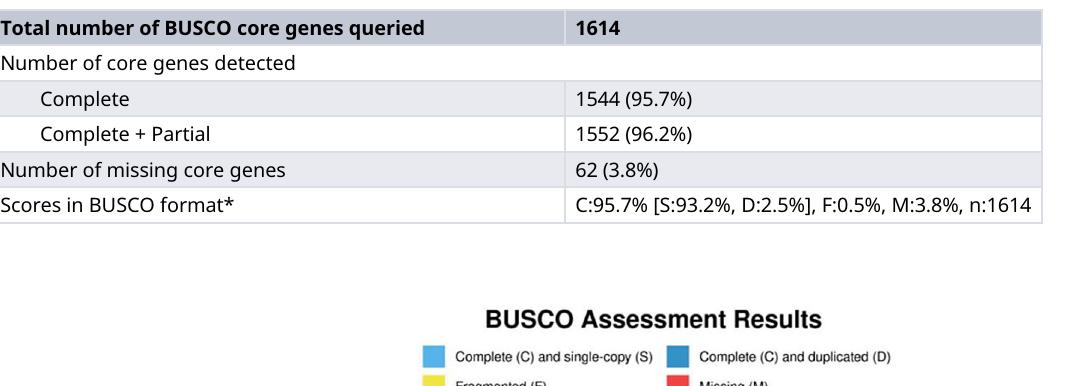
Table 6. BUSCO completeness assessment of protein coding sequences in Z. marina version 3.1.